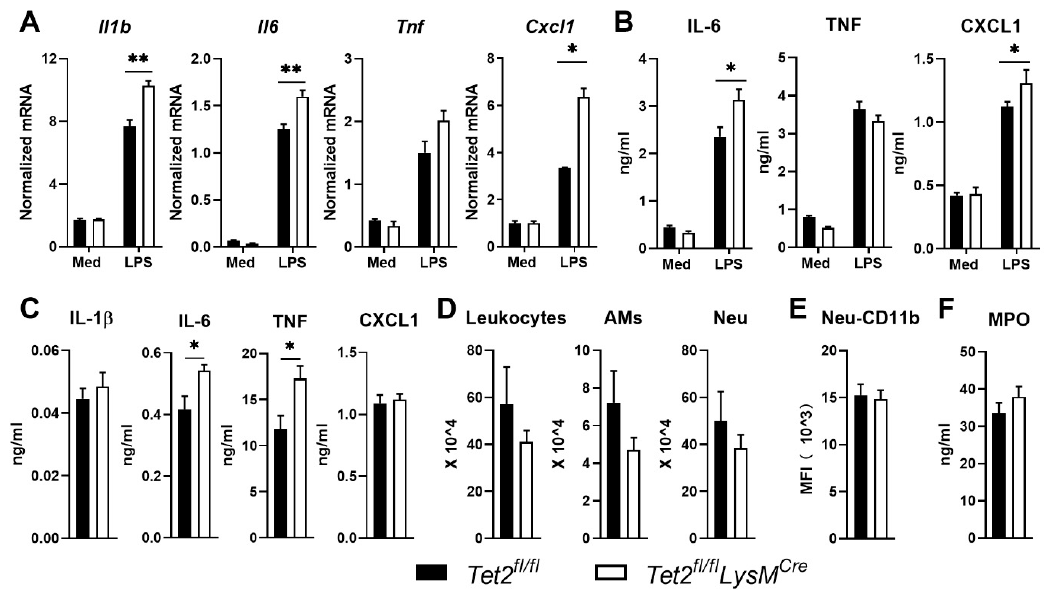
Figure 4. Impact of myeloid Tet2 deficiency on LPS-induced responses by alveolar macrophages in vitro and intact lungs in vivo. ( A ) Ilb , Il6, Tnf and Cxcl1 expression in alveolar macrophages (AMs) from Tet2 fl/fl LysM Cre (open bars) and control mice (black bars) after stimulation with medium control or LPS for 12 h; mRNA expression was normalized to Hprt mRNA; ( B ) IL-6, TNF and CXCL1, production by AMs from Tet2 fl/fl LysM Cre and control mice after stimulation with medium control or LPS for 12 h; ( C ) IL-1 β , IL-6, TNF and CXCL1 protein levels, ( D ) number of total leukocytes, AMs and neutrophils (Neu), ( E ) neutrophil CD11b expression and ( F ) MPO levels in bronchoalveolar lavage fluid from Tet2 fl/fl LysM Cre and control mice 6 h after administration of LPS (1 µg/mouse) via the airways. n = 6 for A and B, n = 8 for C-F. Data are shown as bar graphs with mean ± SEM. p -values were calculated using Mann–Whitney test. * p < 0.05, ** p < 0.01.